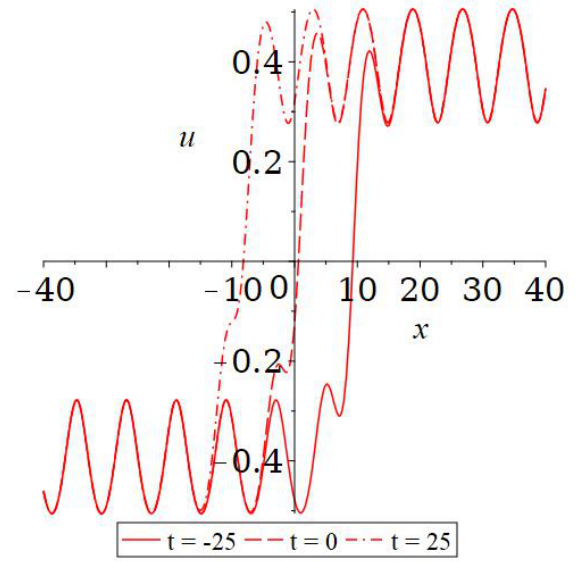
Figure 2. One dimensional image followed by t = − 25,0,25.